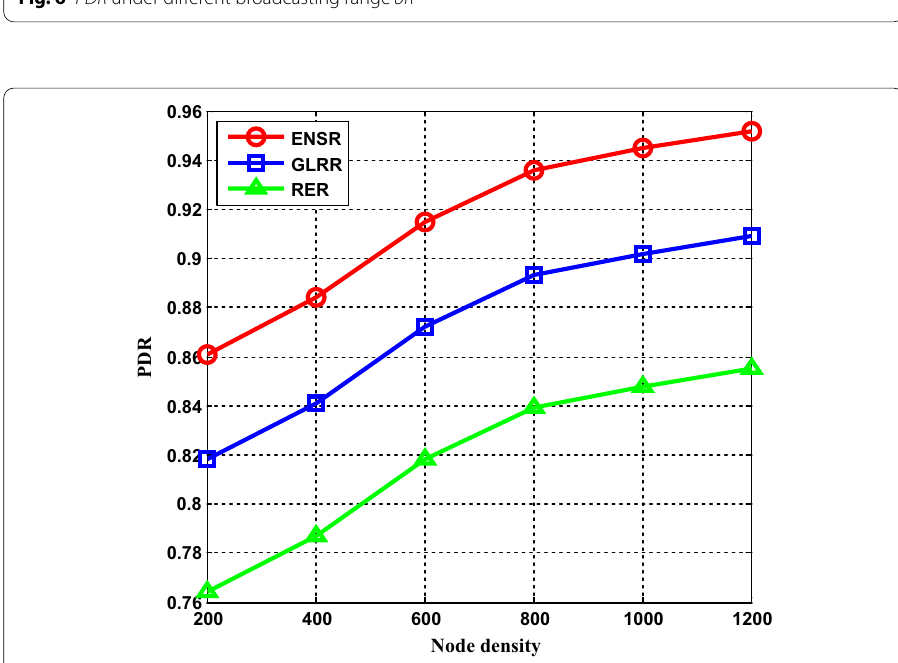
Fig. 7 PDR under different node